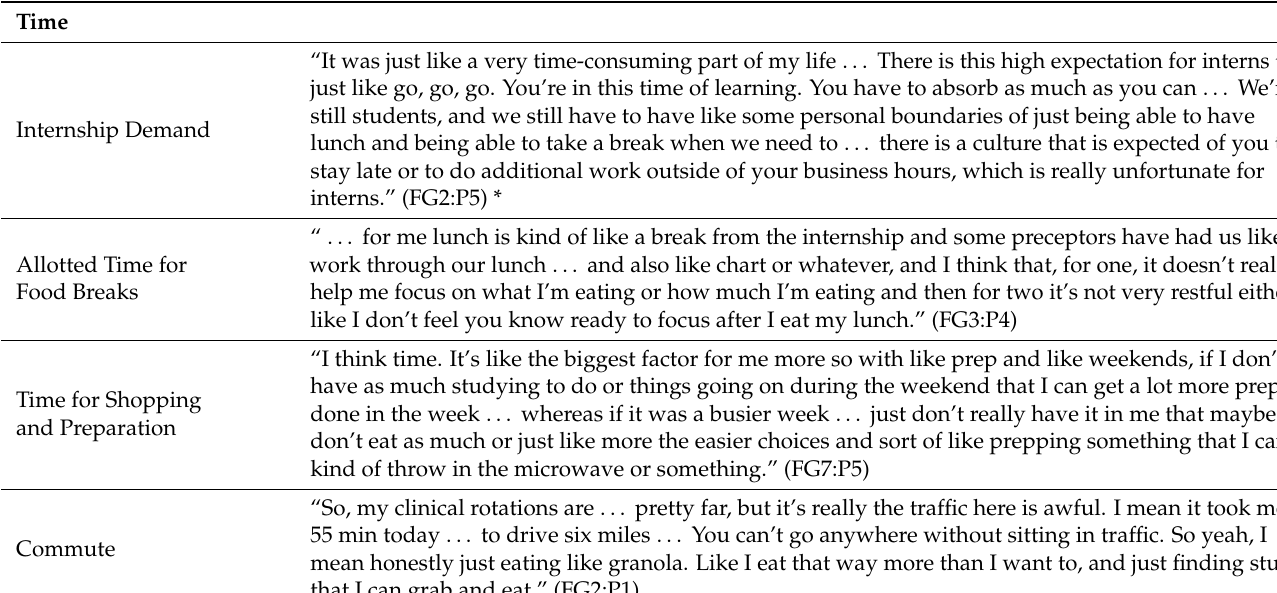
Table 1. Themes, subthemes, and representative quotes from dietetic interns ( n = 42) regarding factors that influenced their dietary intake during supervised